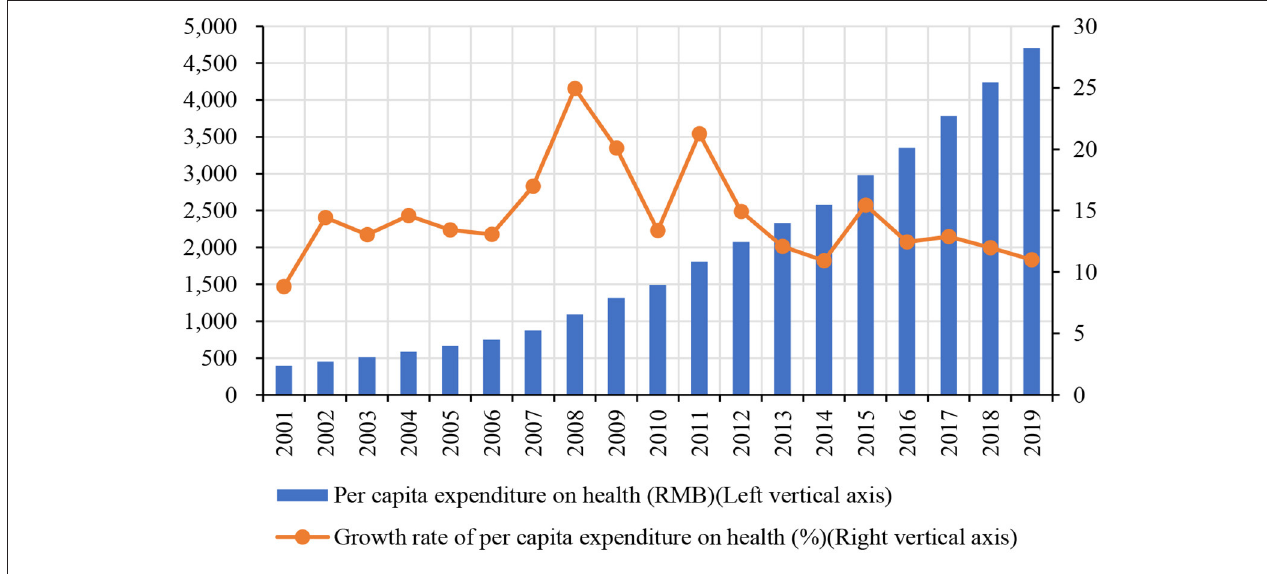
FIGURE 1 | The trend of per capita expenditure on health in China (2000–2019). Data source: National Bureau of Statistics of China